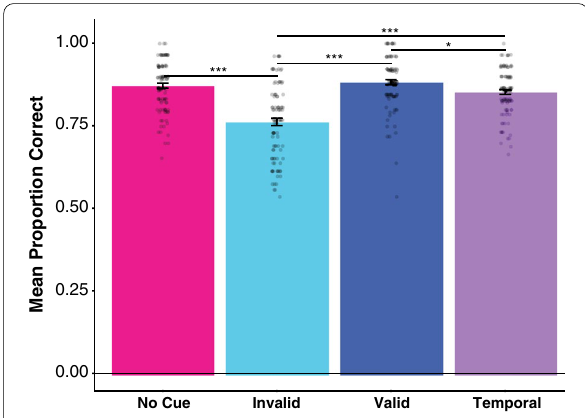
Fig. 4 Mean proportion correct. Each individual dot represents one participant’s mean proportion correct for a given condition. Mean proportion correct in the absence of a cue (no-cue, magenta bar) was 87.1%; invalid spatiotemporal cue (cyan bar), 76.1% ( 11% vs no − cue), valid spatiotemporal cue (navy bar), 88.2% ( 1.1%) and with a + temporal cue (violet bar) 85.2% ( 1.9%). A single asterisk represents p − values < 0.05; three asterisks represent p values < .0001. Error bars are standard error of the